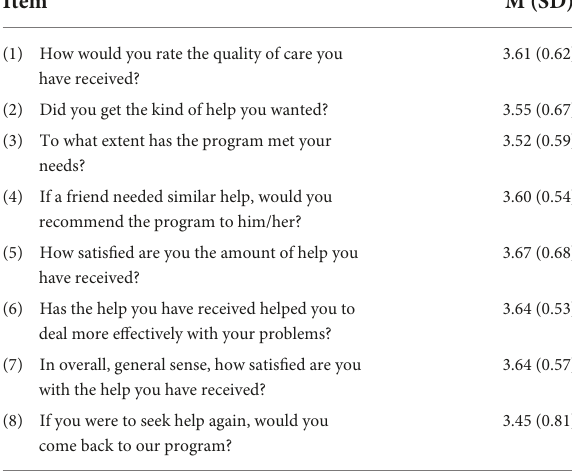
TABLE 6 Rates of perceived benefit from treatment by patients (client satisfaction questionnaire—CSQ-8).